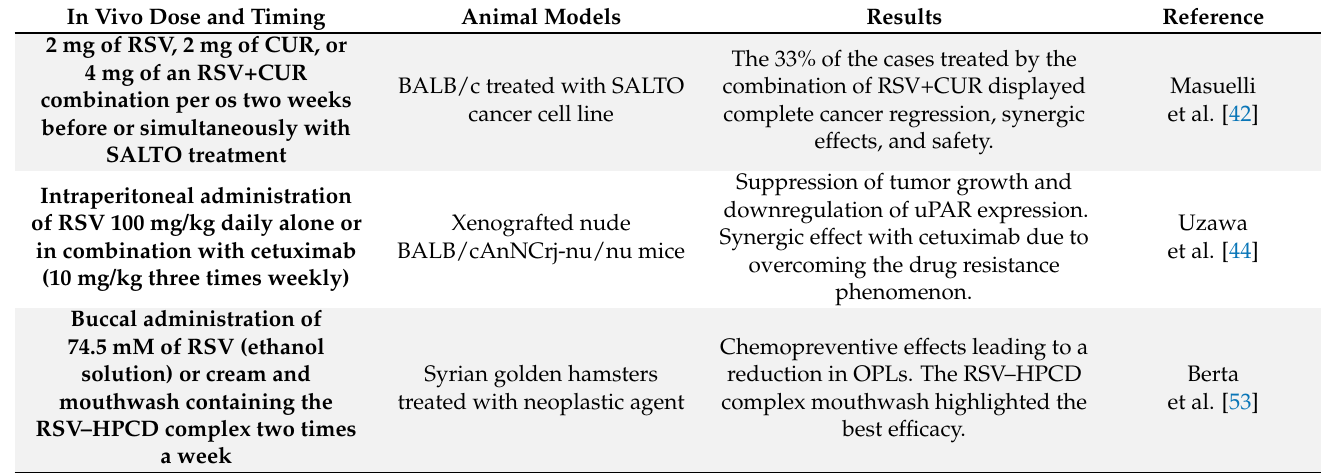
Table 2. Summary of the in vivo chemopreventive, anticancer, and antimetastatic effects of RSV against OSCC-related animal models: tested concentrations, times, and general